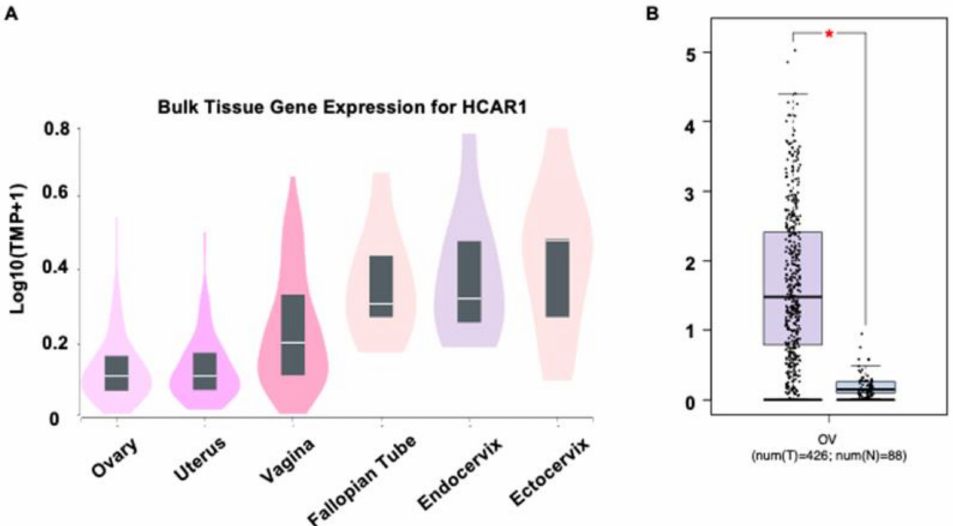
Figure 3. Expression of HCAR1 (hydroxycarboxylic acid receptor 1, HCAR1; formerly known as GPR81) in female reproductive tissues. ( A ) HCAR1 RNA expression in normal female tissues taken from the Genotype-Tissue Expression project (GETx); ( B ) HCAR1 expression in ovarian cancer (OvCa) tissue compared with normal ovarian epithelial tissues (OvCa = 426; n = 88), transcripts per